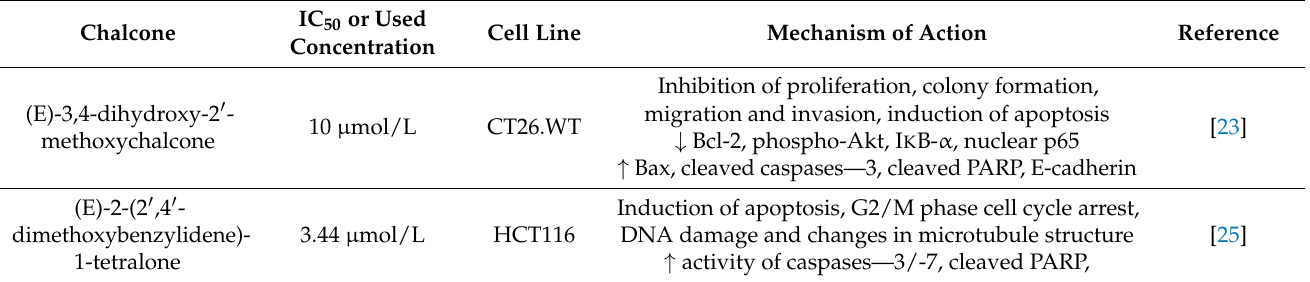
Table 1. Antiproliferative actions of selected chalcones based on in vitro studies. Chalcone Mechanism of